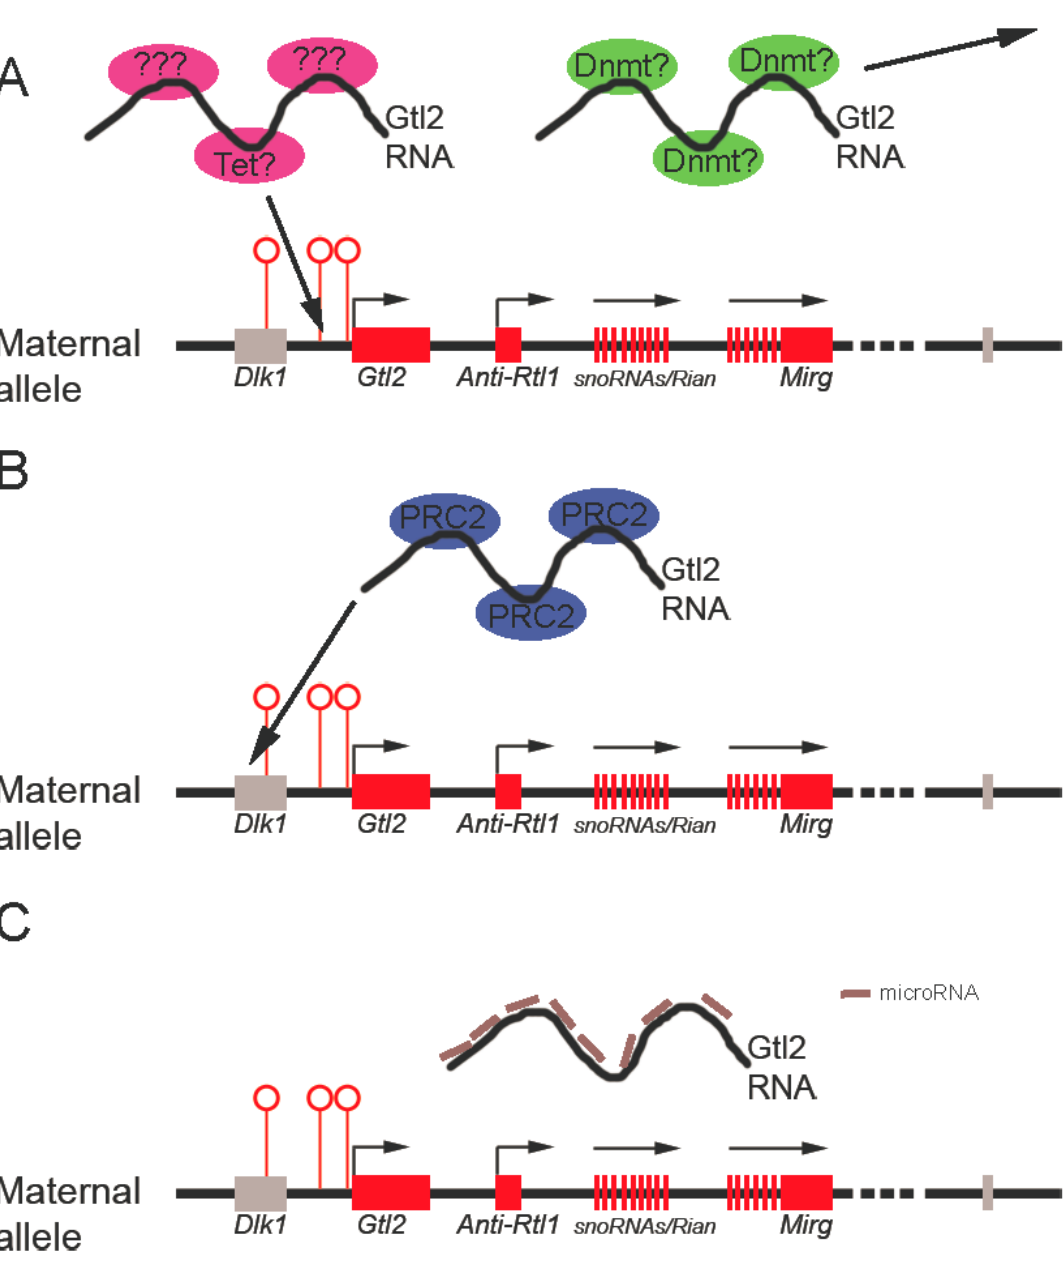
Figure 3. Possible mechanisms underlying Gtl2 regulation of the imprinted Dlk1–Dio3 locus. A. Gtl2 may function to maintain the unmethylated status of the IG-DMR by titrating away DNA methyltransferases (Dnmt in the figure) and/or by recruiting DNA demethylation machinery (such as Tet or unknown proteins). B. Gtl2 could silence Dlk1 expression by recruiting PRC2 complexes to the Dlk1 genomic region. C. Finally, Gtl2 may serve as competitive endogenous RNA (ceRNA) to keep maternally-expressed genes active by titrating away inhibitory microRNAs targeting those genes. Red rectangles represent maternally- expressed genes. Gray rectangles represent repressed genes. Open circles represent unmethylated